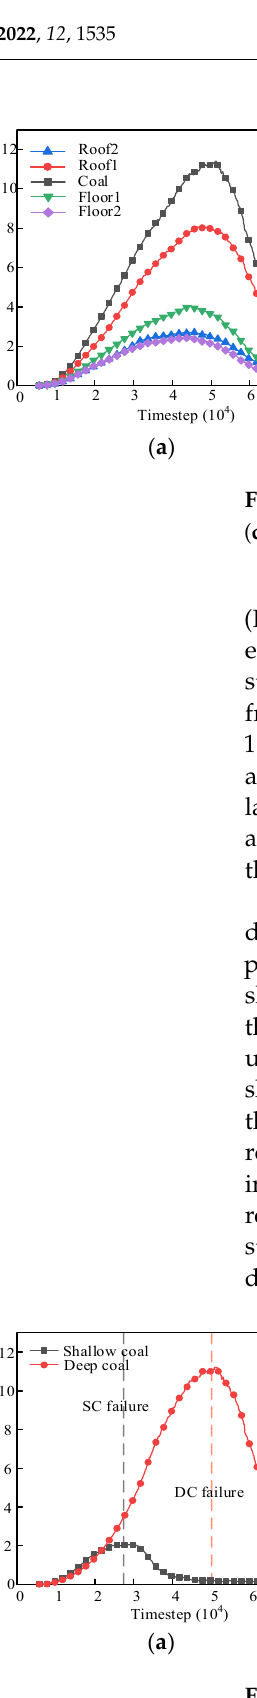
( c ) Figure 10. Energy evolution law of roadway surrounding rock. ( a ) RSR-1; ( b ) RSR-2; ( c ) RSR-3. The strain energy evolution law of each rock layer was similar to that of the whole